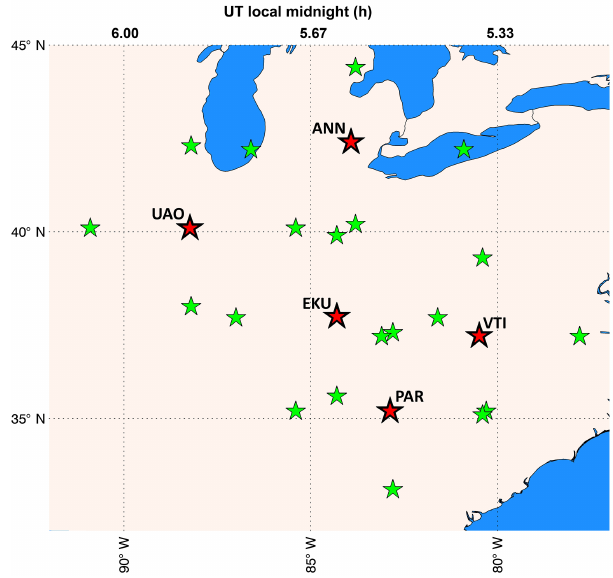
Figure 1. NATION Cardinal Mode FPI observing configuration. Red and green stars mark the NATION site position and the mea- surement locations, respectively, for the North, East, South, and West directions assuming a 630nm 250km altitude. Red stars also represent the positions of the Zenith measurement. The top axis rep- resents the local midnight in universal